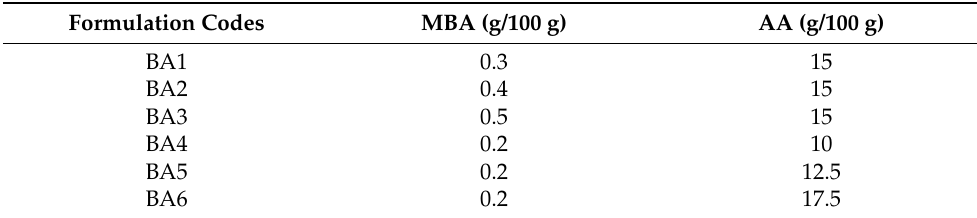
Table 1. Composition of black seed polysaccharide (BSPE)-g-poly (acrylate) hydrogel formulations (BA1-BA6) * with varying N, N -methylene bisacrylamide (MBA) and acrylic acid (AA) contents. Formulation